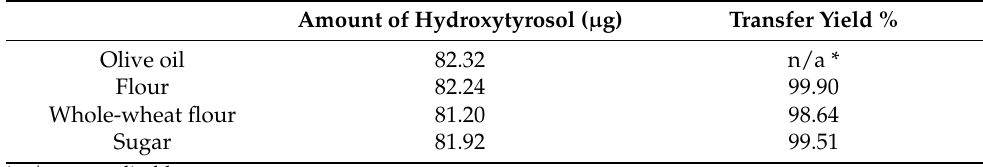
Table 1. Amount of hydroxytyrosol transferred to food from a commercial olive oil and transfer yields. Amount of Hydroxytyrosol ( μ g) Transfer Yield % Olive oil 82.32 Flour